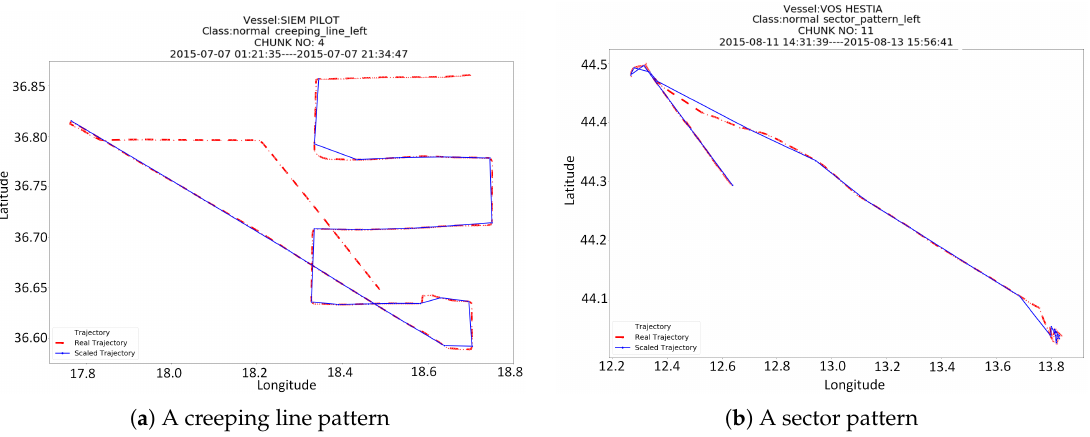
Figure 7. Selected plots from real trajectories that have been classified to SAR